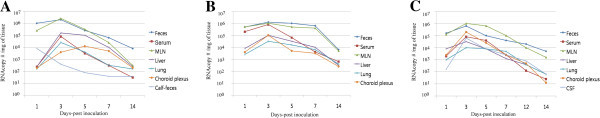
Quantification of RVA RNA copy numbers by SYBR Green real-time RT-PCR in the feces, serum, mesenteric lymph node (MLN), liver, lung, and choroid plexus. (A) The sequential changes of viral RNA copy numbers of a porcine G5P[7] strain in the feces, serum, MLN, liver, lung and choroid plexus sampled from virus-infected piglets. Fecal specimens sampled from porcine G5P[7] K71 strain-inoculated calves were also examined by real-time RT-PCR. Note that viral RNA copy numbers in the feces from virus-inoculated calves were markedly lower than those from virus-inoculated piglets. (B and C) The sequential changes of viral RNA copy numbers in the feces, serum, MLN, liver, lung, and choroid plexus sampled from virus-inoculated piglets (B) or calves (C) were similar to each other. The geometric means of virus RNA copy numbers per mg of each sample are displayed.